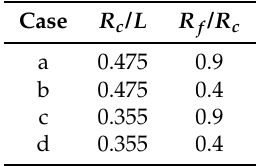
Table 2. Chosen geometry for the unit